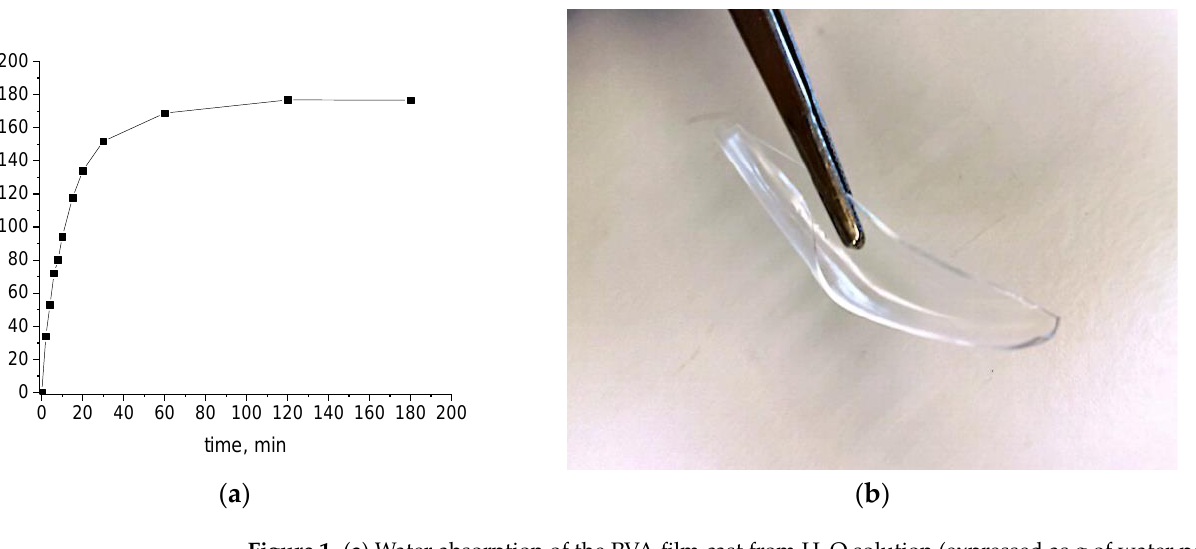
Figure 1. ( a ) Water absorption of the PVA film cast from H 2 O solution (expressed as g of water per g of dry film), as a function of time (the line was added only as a visual aid); ( b ) Photo of the swollen PVA film showing the retention of its initial shape.